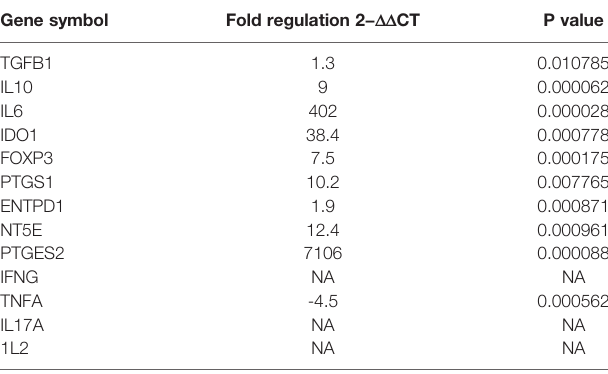
TABLE 4 | Upregulated and downregulated genes in mDCs after co-cultured with primed WJ-MSCs. Gene symbol Fold regulation 2 − DD CT